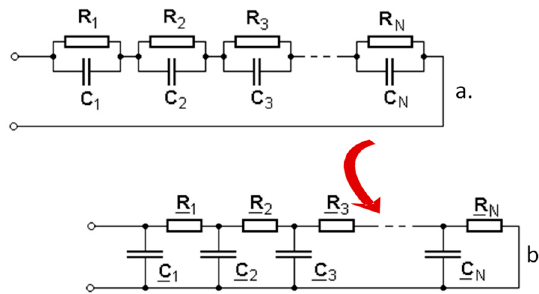
Figure 8. Foster- ( a ) and Cauer- ( b ) type representations of a 3D thermal RC net (based on Reference [4]).